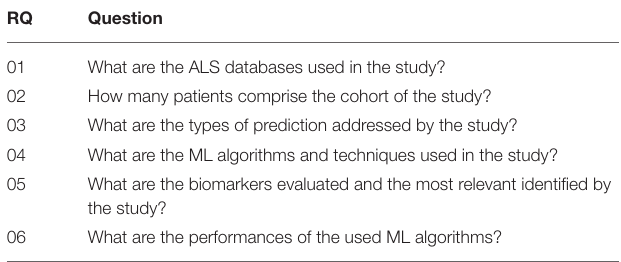
TABLE 1 | Research